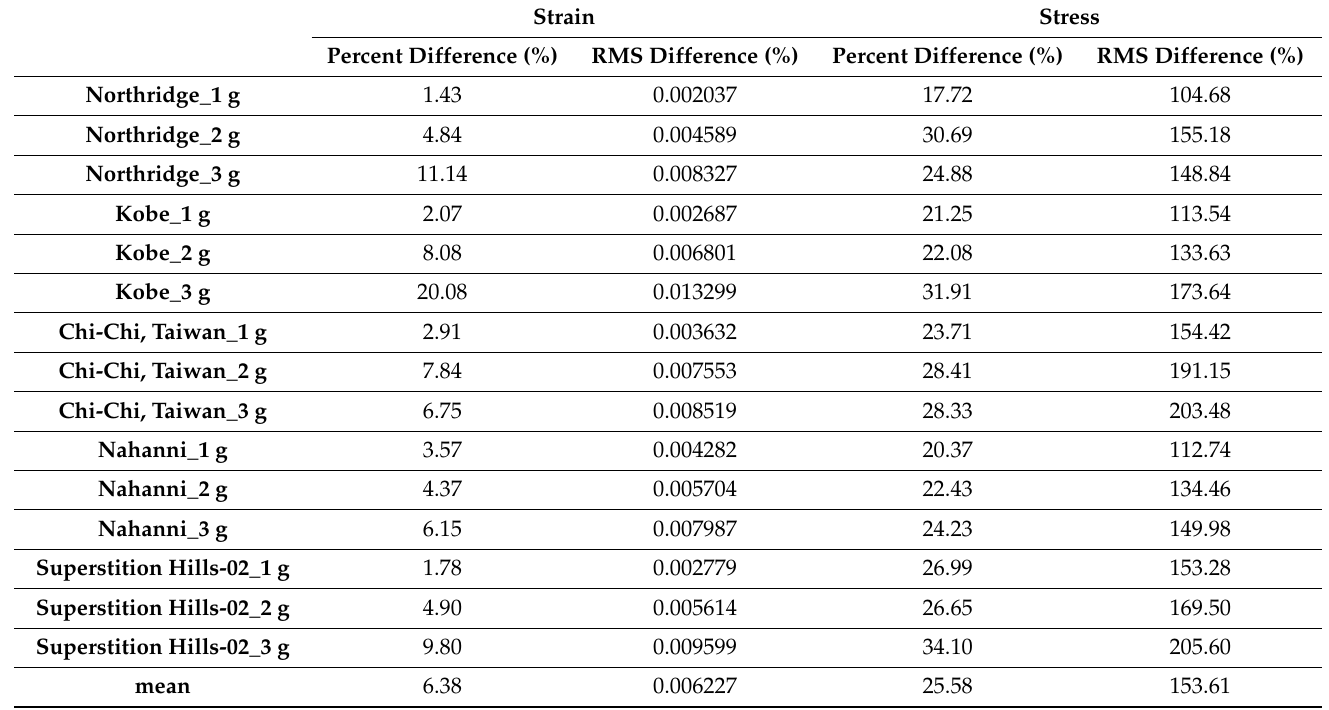
Table 8. Difference in the stress and strain of piping according to the convergence conditions. Strain Stress Percent Difference (%) RMS Difference